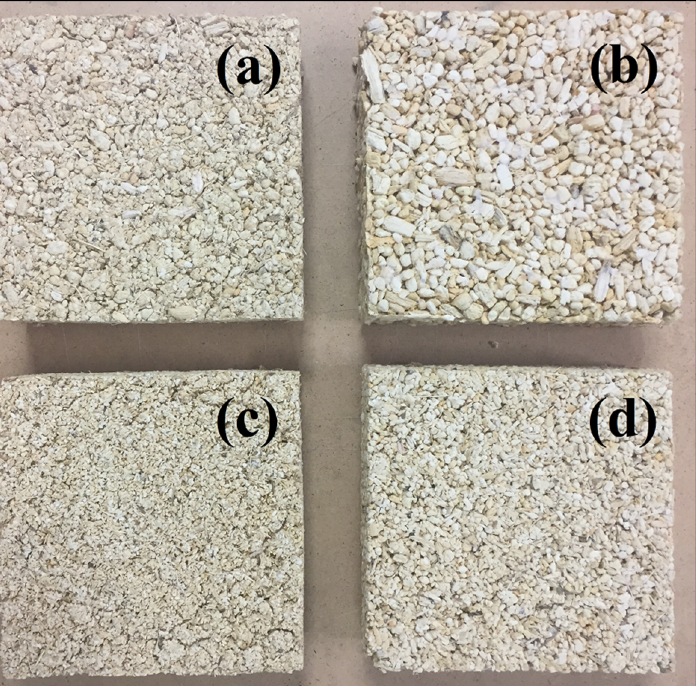
Figure 3. ( a ) Photograph of the low-density insulation block made from the MP sieved fraction of pith particles; ( b ) Photograph of the low-density insulation block made from the BP sieved fraction of pith particles; ( c ) Photograph of the low-density insulation block made from the SP sieved fraction of pith particles; ( d ) Photograph of the low-density insulation block made from the mix of the SP, MP, and BP pith particles. All the insulation blocks have a 10% ( w / w ) starchy binder content. However, these results are only preliminary, and some improvements are still